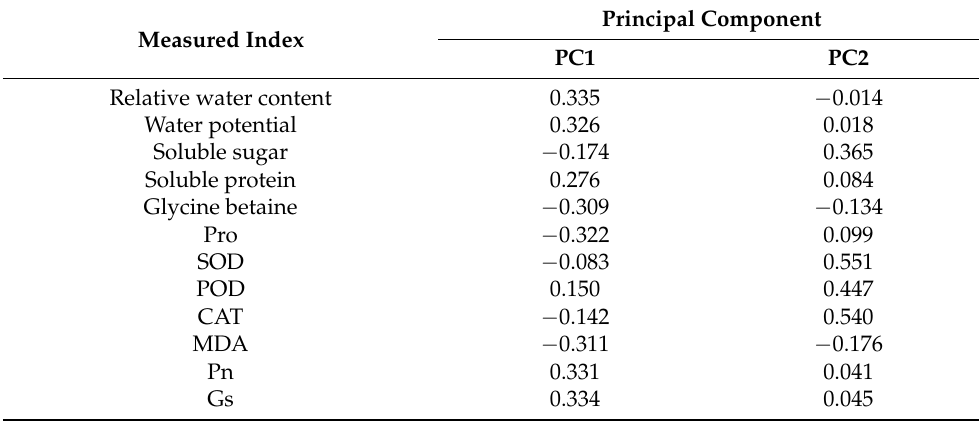
Table 1. Eigenvalue and cumulative contribution rate of each index of four oak